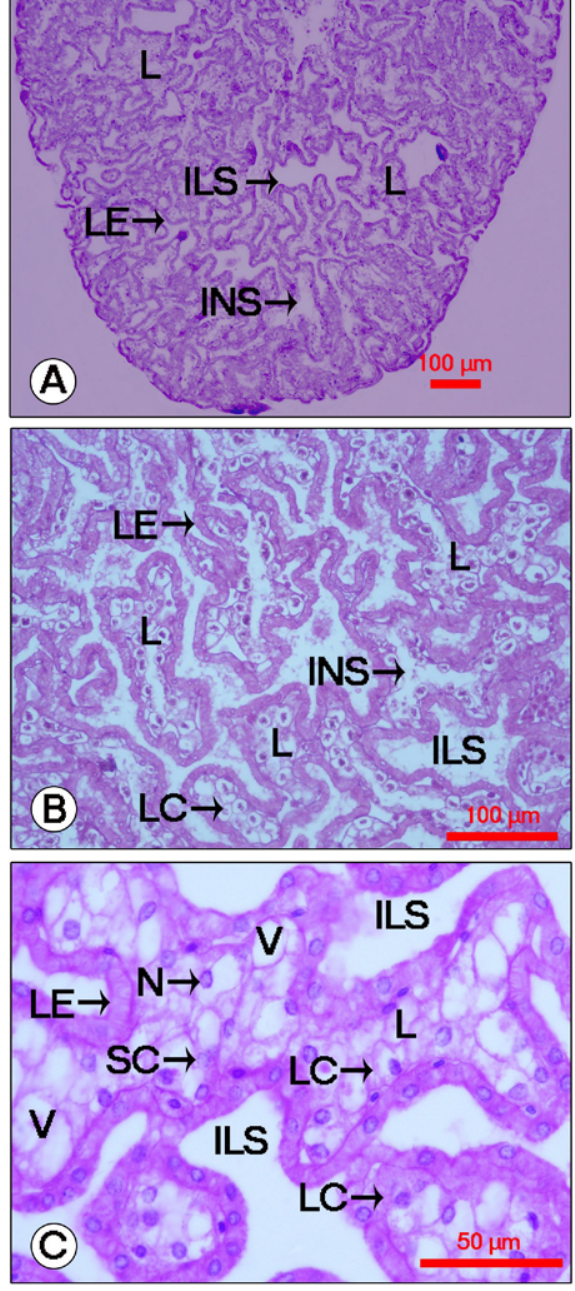
Figure 2. Light micrograph of control Y-organ during C3 stage in Travancoriana schirnerae. ( A, B ) Small loosely arranged lobules with prominent intra- and inter-lobular spaces. ( C ) Enlarged view of lobules showing monolayered lobular epithelium, gland cells and vacuoles. ILS: Inter-lobular space; INS: Intra-lobular space; L: Lobule; LC: Larger cell; LE: Lobular epithelium; N: Nucleus; SC: Smaller cell; V: Vacuole.